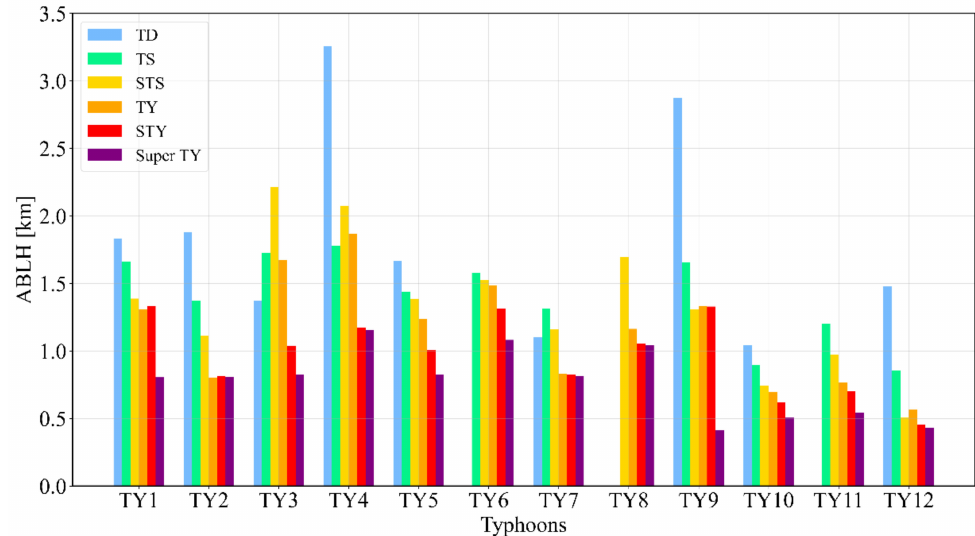
Figure 9. Comparison of the mean ABLHs between different stages of each typhoon. Different colors represent the six stages, defined by the CMA, according to wind